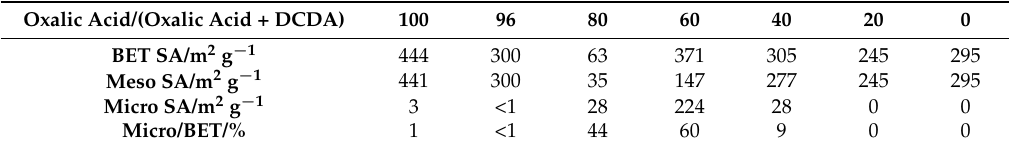
Table 1. Summary of the results obtained from N 2 sorption measurements. SA is used as surface area and DCDA as